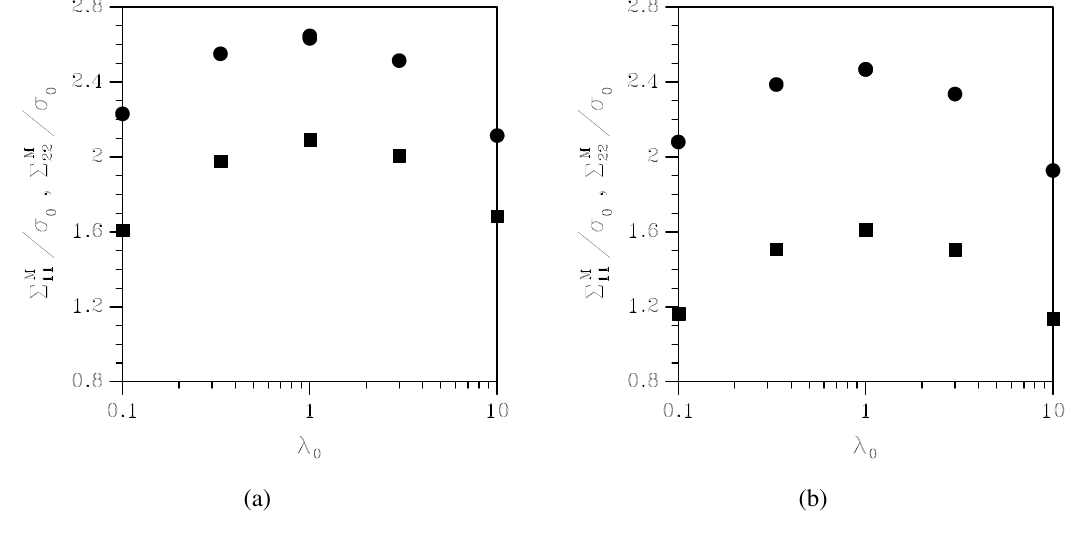
on the peak values of Chauchy stresses Σ 0 = 0 . 0 , and (b) k = − 0 . 5 ε ε